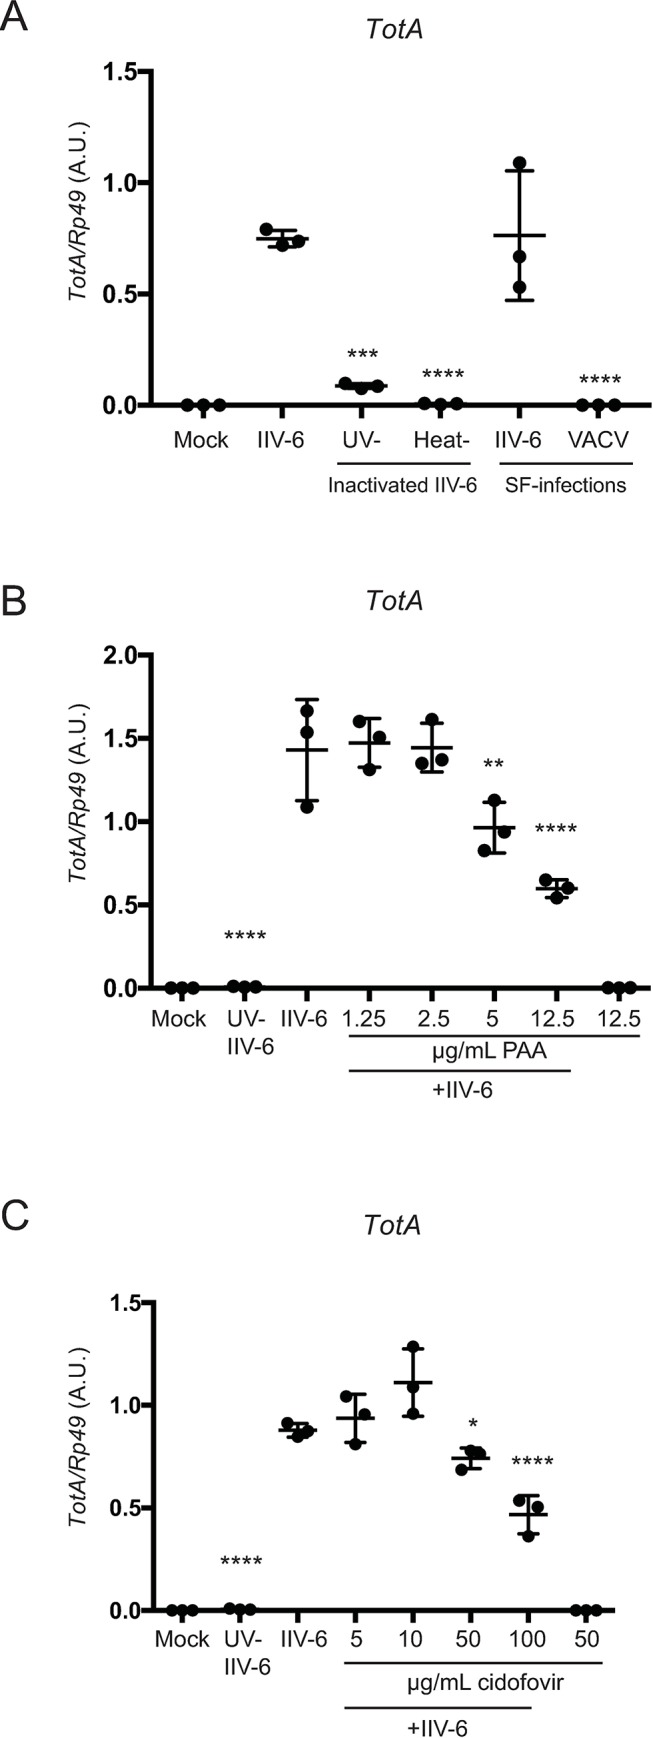
Viral replication is required for IIV-6 induced turandot expression.A) S2* cells were infected with heat- or UV-inactivated IIV-6 or infected with VACV or IIV-6 in serum-free (SF) media, and TotA induction was assayed by qRT-PCR. B, C) S2* cells were treated with the viral polymerase inhibitors B) phosphonoacetic acid (PAA) or C) cidofovir at the indicated concentrations for one hour prior to IIV-6 infection. For all panels, TotA induction was assayed at 24 hours post-infection by qRT-PCR. Significance, compared to IIV-6 infected samples without treatment or drugs, was determined by one-way ANOVA and Sidak’s multiple comparisons test (* p < 0.05; *** p < 0.001; and **** p < 0.0001). Error bars indicate standard deviation and black bars indicate the mean. A.U., Arbitrary Units.